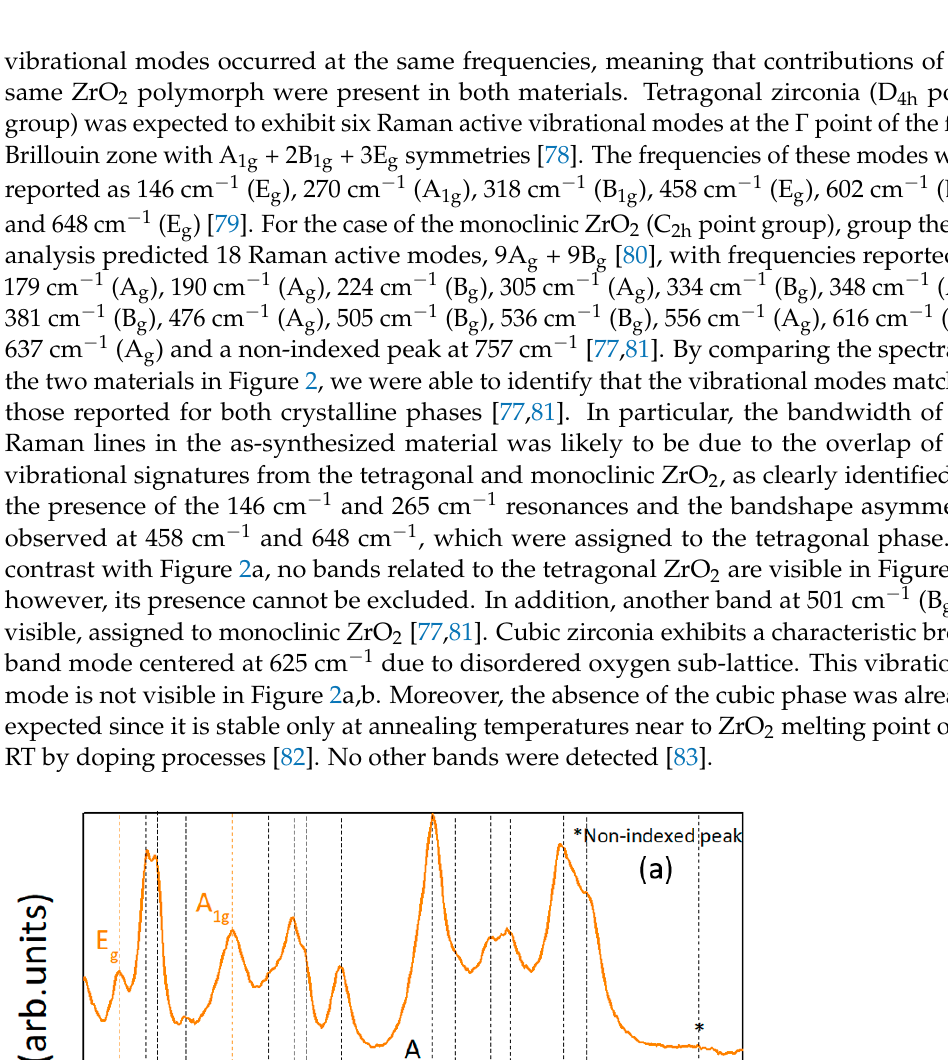
Figure 3. ( a ) In situ XRD diffractograms of the ZrO 2 nanopowder synthesized under microwave irradiation with different annealing temperatures ranging from RT to 800 °C with a plateau time of 15 min. For comparison, the simulated monoclinic, tetragonal and cubic zirconia structures are also